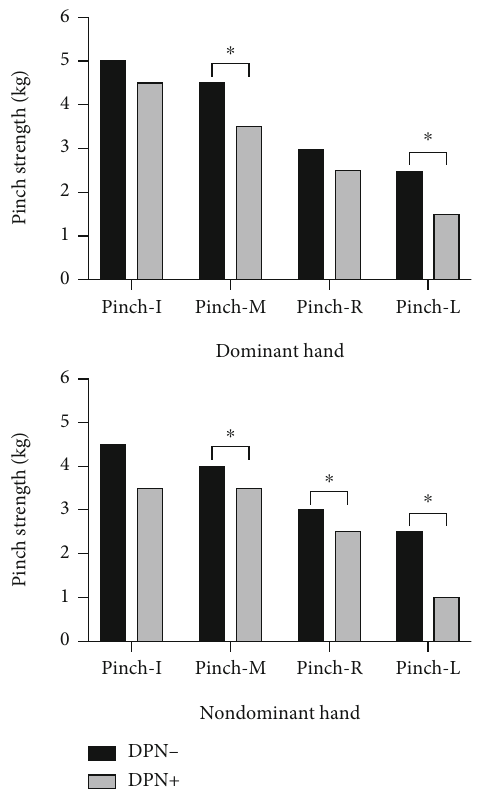
Figure 4: Di ff erences in pinch strength between the thumb and the other four fi ngers in both hands. Pinch-I: thumb-index fi ngertip pinch strength; Pinch-M: thumb-middle fi ngertip pinch strength; Pinch-R: thumb-ring fi ngertip pinch strength; Pinch-L: thumb- little fi ngertip pinch strength. ∗ A p value < 0.05 was considered to indicate statistical signi fi